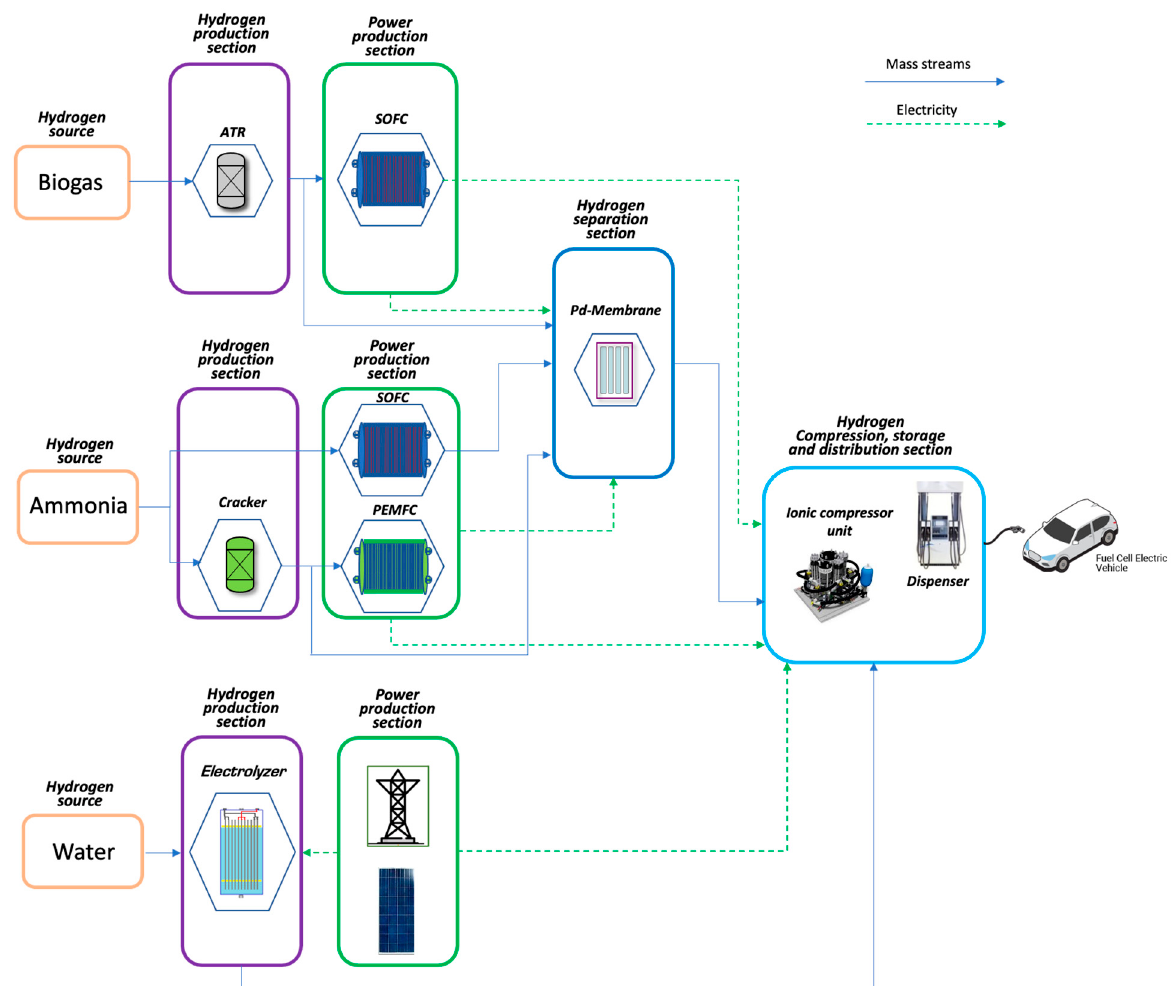
Figure 1. On-site Hydrogen Refuelling Stations concepts.